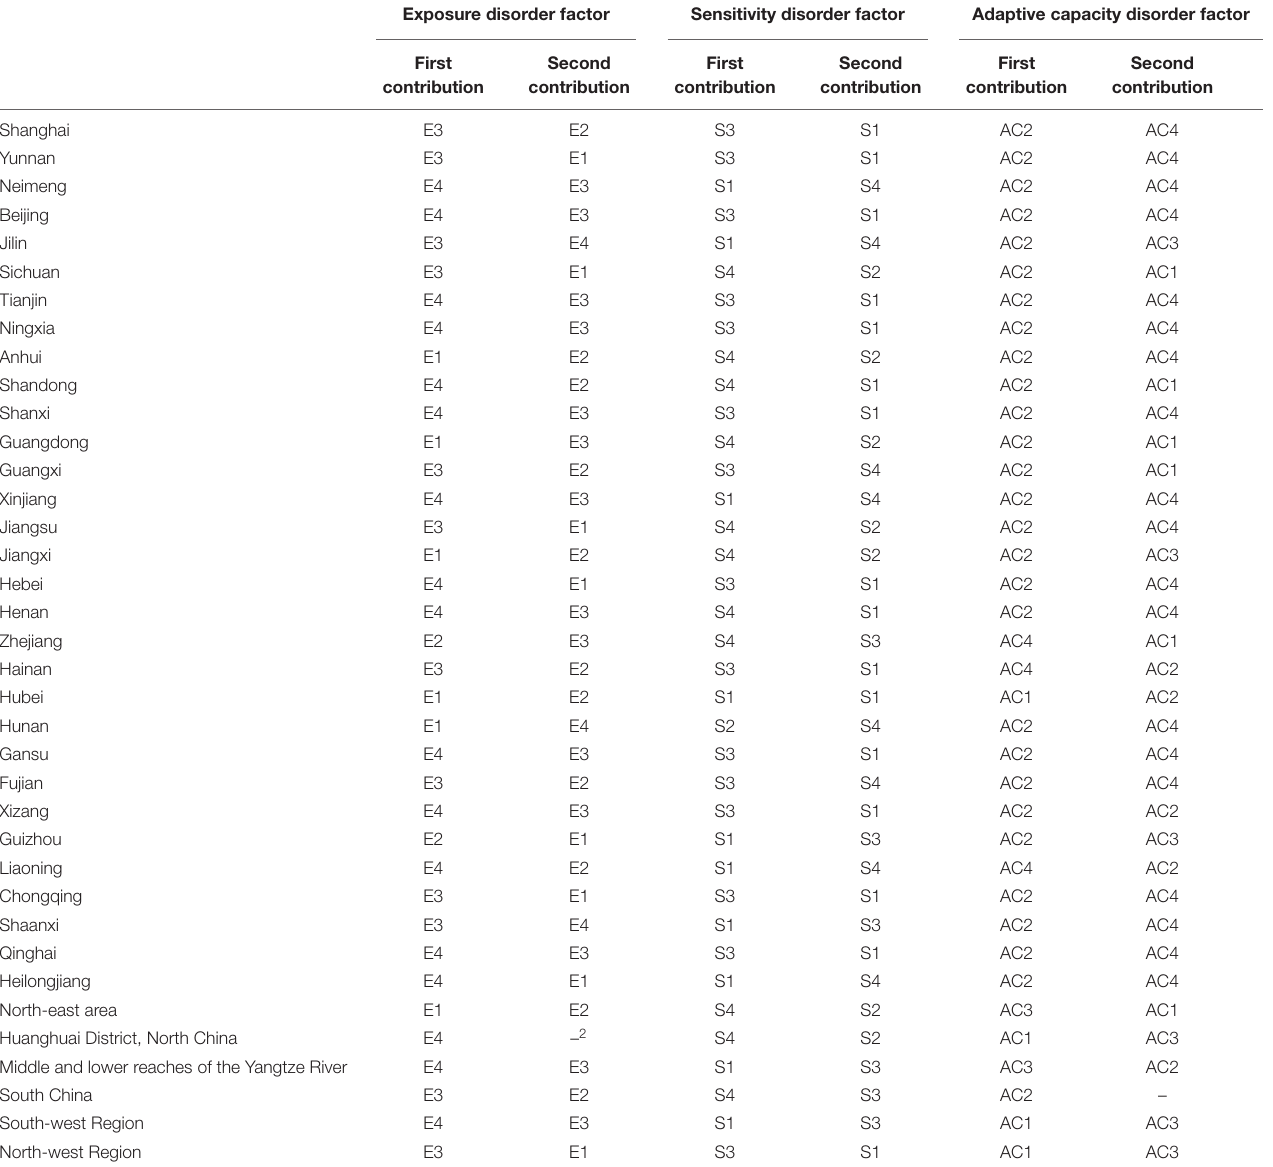
TABLE 2 | Contribution of each index factor of vulnerability to flood disasters of inland fisheries in China in 2019 1